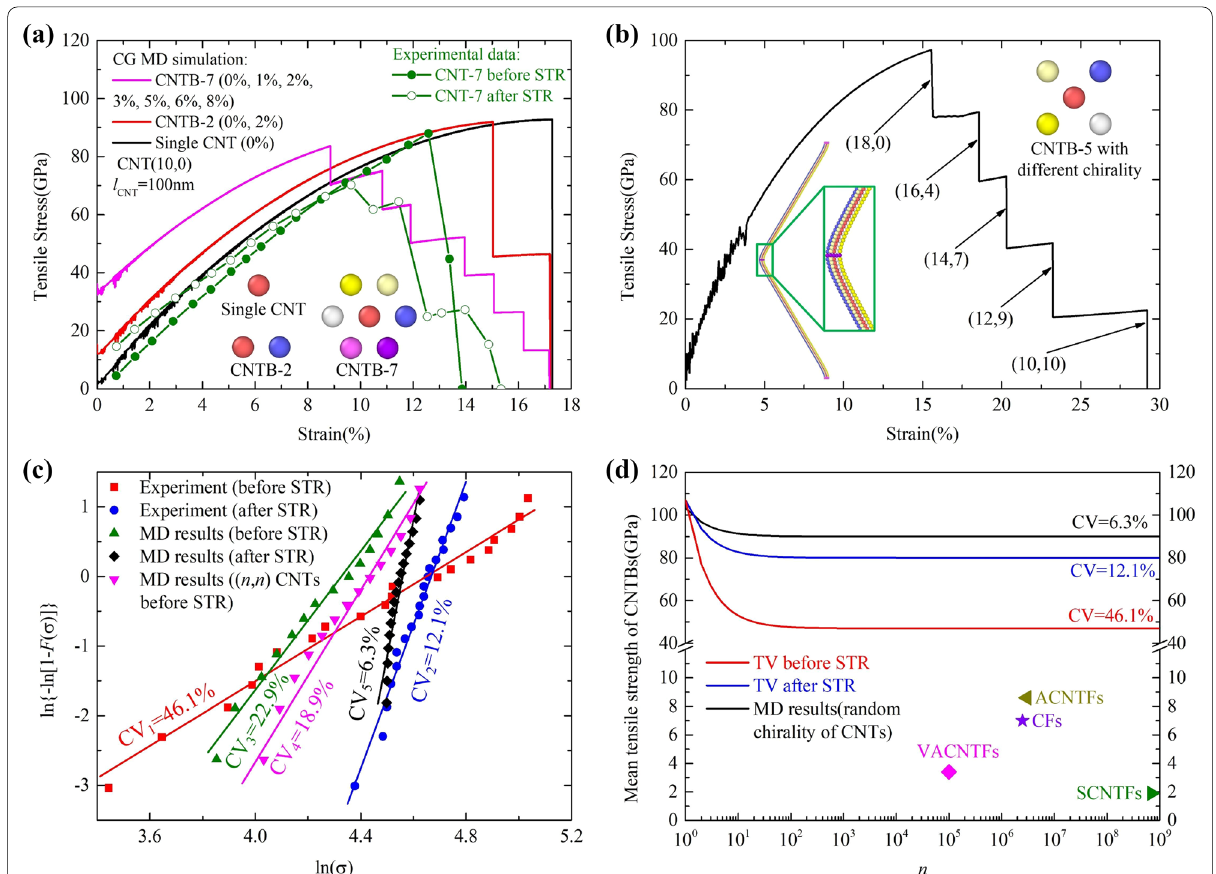
Figure 13 ( a ) The stress-strain curves of a single (10, 0) CNT, CNTB-2, CNTB-3 and CNTB-7 with different initial strains, ( b ) the stress-strain curves of the CNTB-5 (including (18,0), (16,4), (14,7), (12,9) and (10,10)), ( c ) the CV values of CNT bundles before and after the STR treatment and CG MD results, ( d ) the relationship between the mean tensile strength of CNTBs and their component number before and after STR treatment and CG MD results [8,